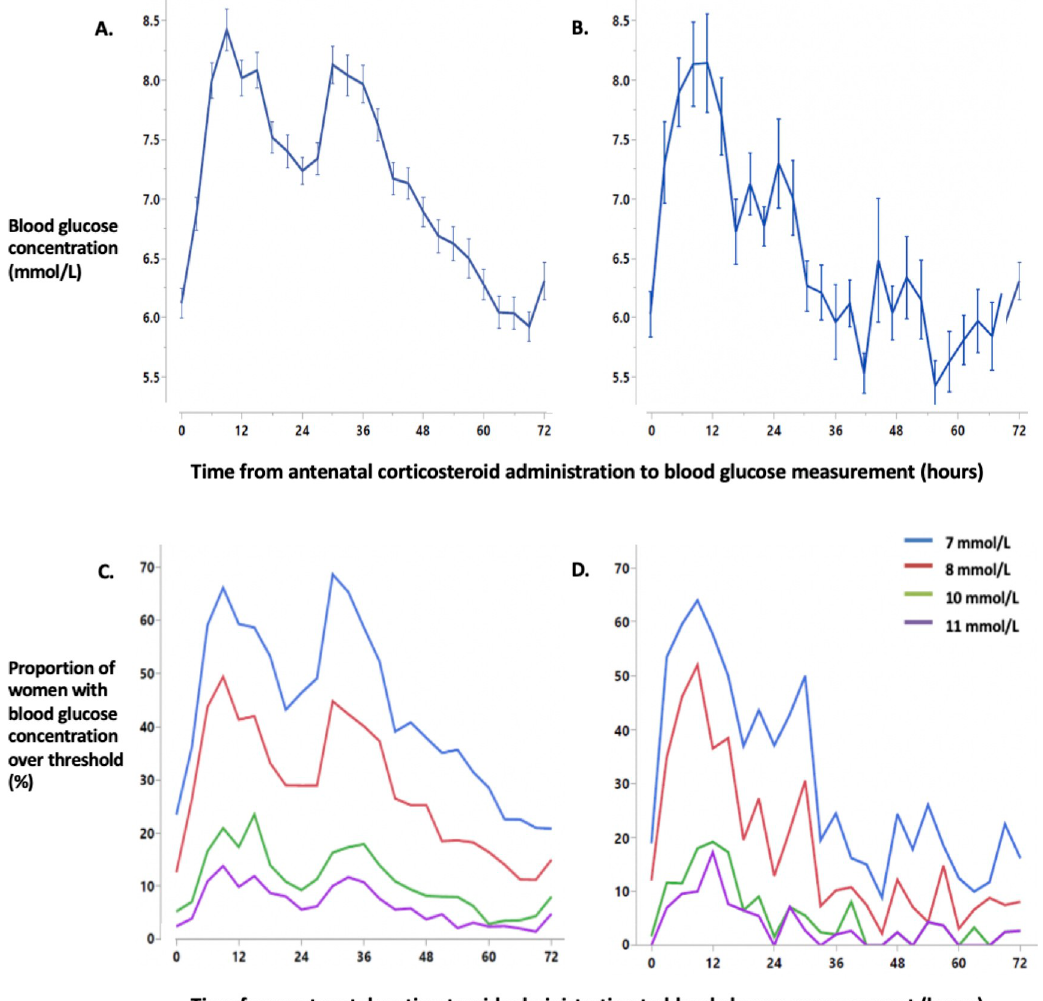
Fig 1. Mean blood glucose concentration and the percentage of women with a blood glucose measurement over threshold after an initial course of antenatal corticosteroids (panels A and C) and the last repeat course (panels B and D). Data for blood glucose concentration are mean with standard error. Blood glucose concentration data were analysed in 3-hour epochs. Time “0” represents blood glucose concentration values from three hours prior to the first dose of ANC administration in a course until antenatal corticosteroid administration. Panel A, mean blood glucose concentration after an initial course of ANC. Panel B, mean blood glucose concentration after the last repeat course of ANC. Panel C, the proportion of women with blood glucose over each hyperglycaemic threshold after the initial course of ANC. Panel D, the proportion of women with blood glucose over each hyperglycaemic threshold after the last repeat course of ANC.